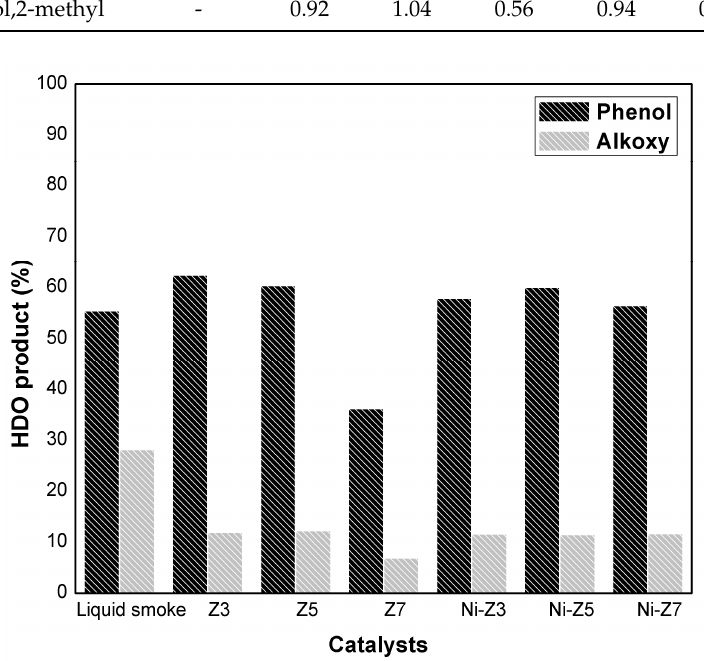
Figure 9. The effect of catalyst variations on HDO products. Figure 9. The e ff ect of catalyst variations on HDO